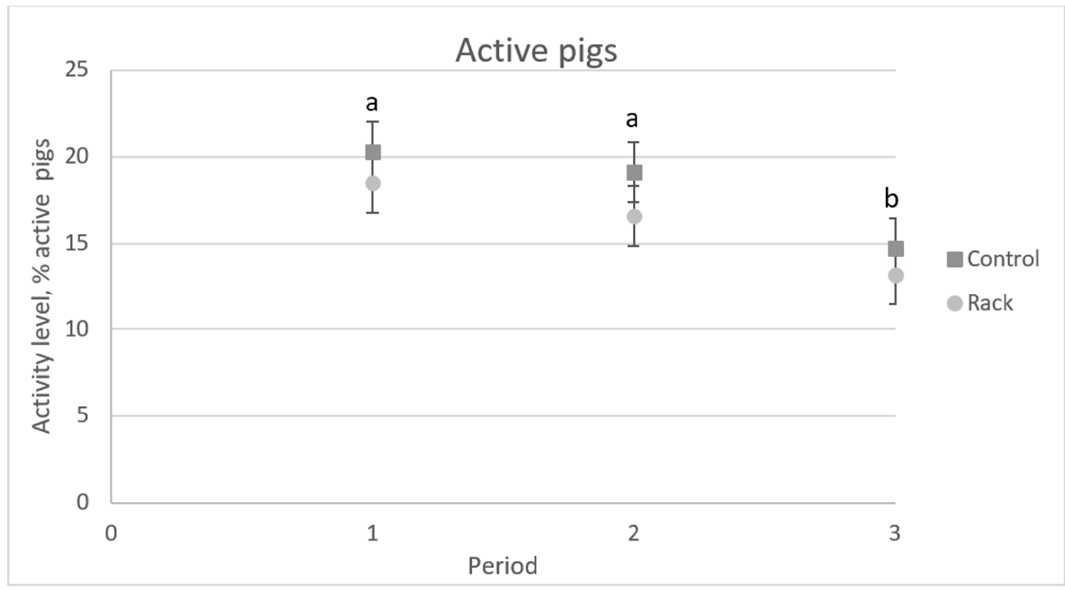
Figure 3. Activity levels of pigs over time. Treatment had no effect on activity levels, while period had a significant effect where pigs were significantly less active in period 3 (week 11) compared to periods 1 (week 2) and 2 (week 6). Different letters (a, b) indicate significant difference between periods. N = 30. Table 3. Final models used for evaluation of treatment effect (RACK vs CONTROL) on activity lev- els and exploratory behaviours. The interaction between treatment and period (Treatment*Period) was removed from the model if proven non-significant based on AIC values.